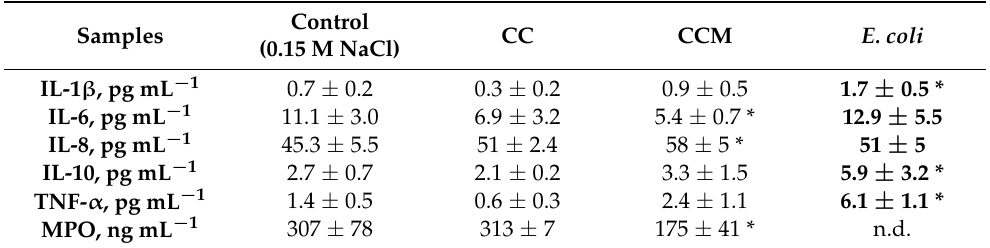
Table 2. Extracellular concentration of cytokines and myeloperoxidase after incubation of neutrophils with CC and CCM microparticles and bacteria E. coli for 1 h at 37 ◦ C. All measurements were performed in